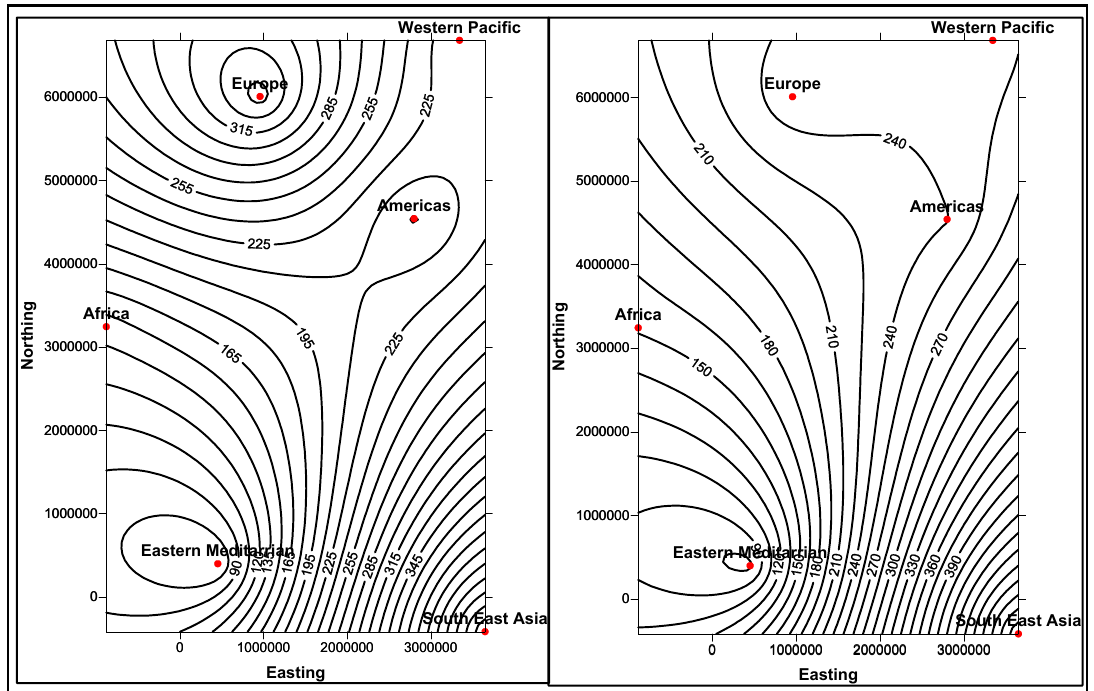
Figure 17. Map views showing diabetes deaths for different regions (male and female, in